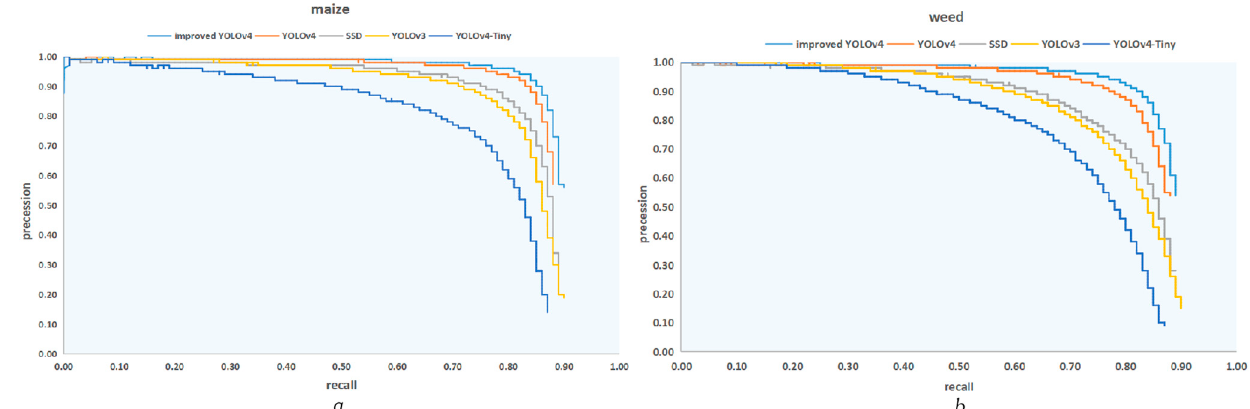
Figure 9. The PR curves of different models. The curve area from largest to smallest is: improved YOLOv4, YOLOv4, SSD, YOLOv3, and YOLOv4-Tiny. ( a ) PR curve of maize, and ( b ) PR curve of weed.